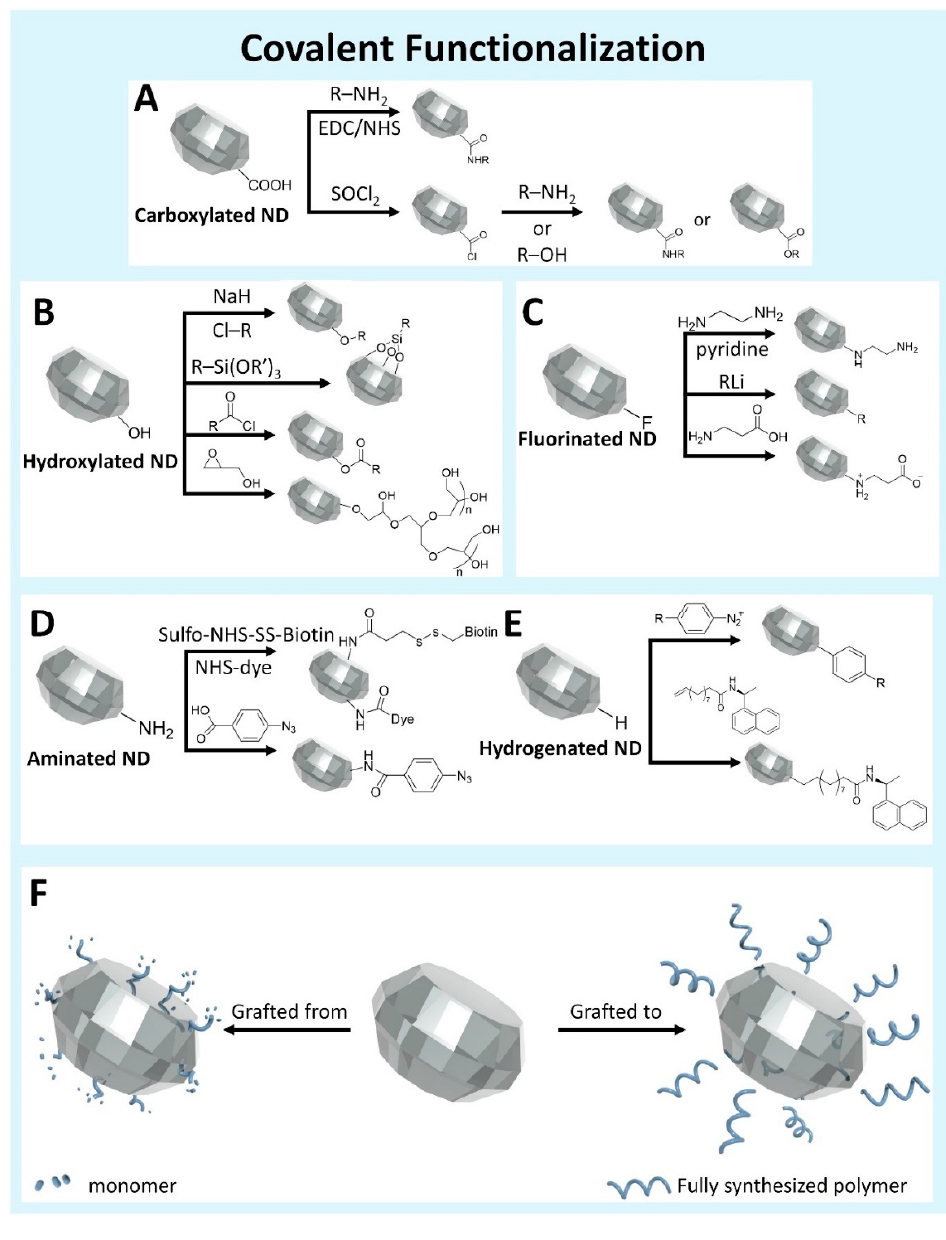
Figure 3. A variety of functionalization methods can be achieved through covalent surface modification of NDs surface based on the initial surface group on the homogenized NDs surface [58,81–85]. ( A ) Carboxylic acid coupling to amines or alcohols. ( B ) Hydroxyl group initiated functionalization. ( C ) Substitution based coupling with halogenated NDs. ( D ) Amine coupling to NHS esters or Carboxylic acids. ( E ) Generation of robust carbon–carbon single bonds from hydrogenated ND. ( F ) Polymer coating by direct polymerization reaction on ND surface (left, grafted from), or coupling of fully synthesized polymer to ND surface (right, grafted to) [86,87].